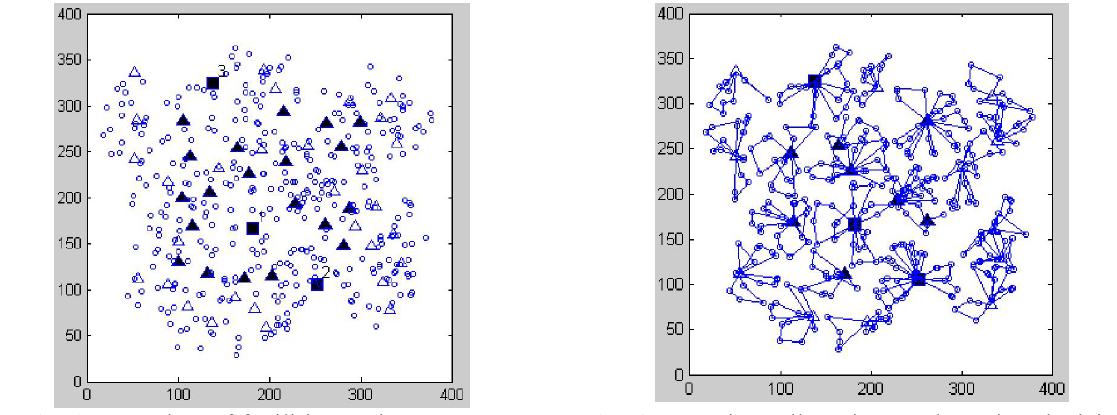
Fig. 5. Transshipment paths (product 1)